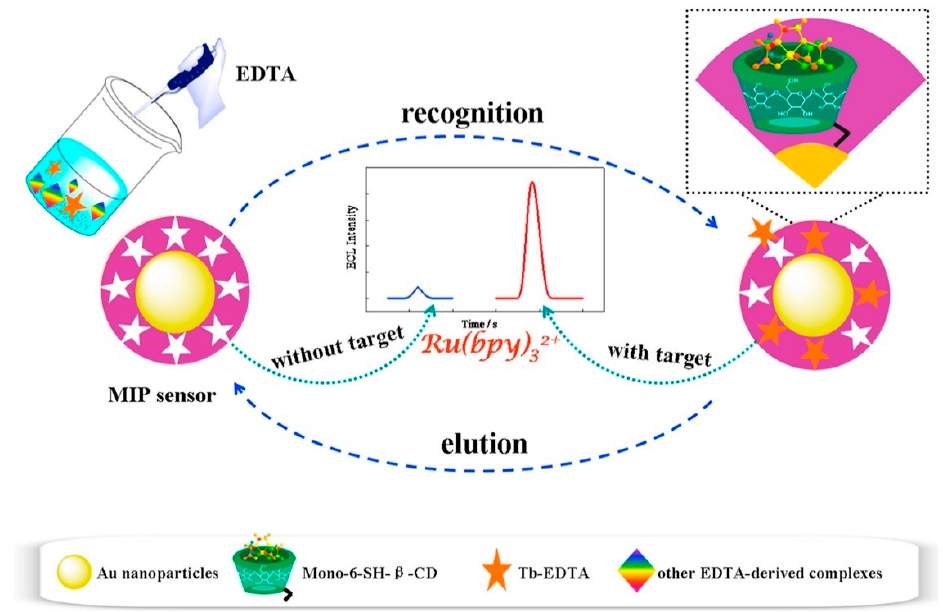
Figure 10. Scheme of the Russian Matryoshka structured molecularly imprinted sensor for ultra-trace + determination as Tb-EDTA complex. Reproduced from [154] with permission of Tb 3+ determination as Tb-EDTA complex. Reproduced from [154] with permission of Elsevier. Tb 3